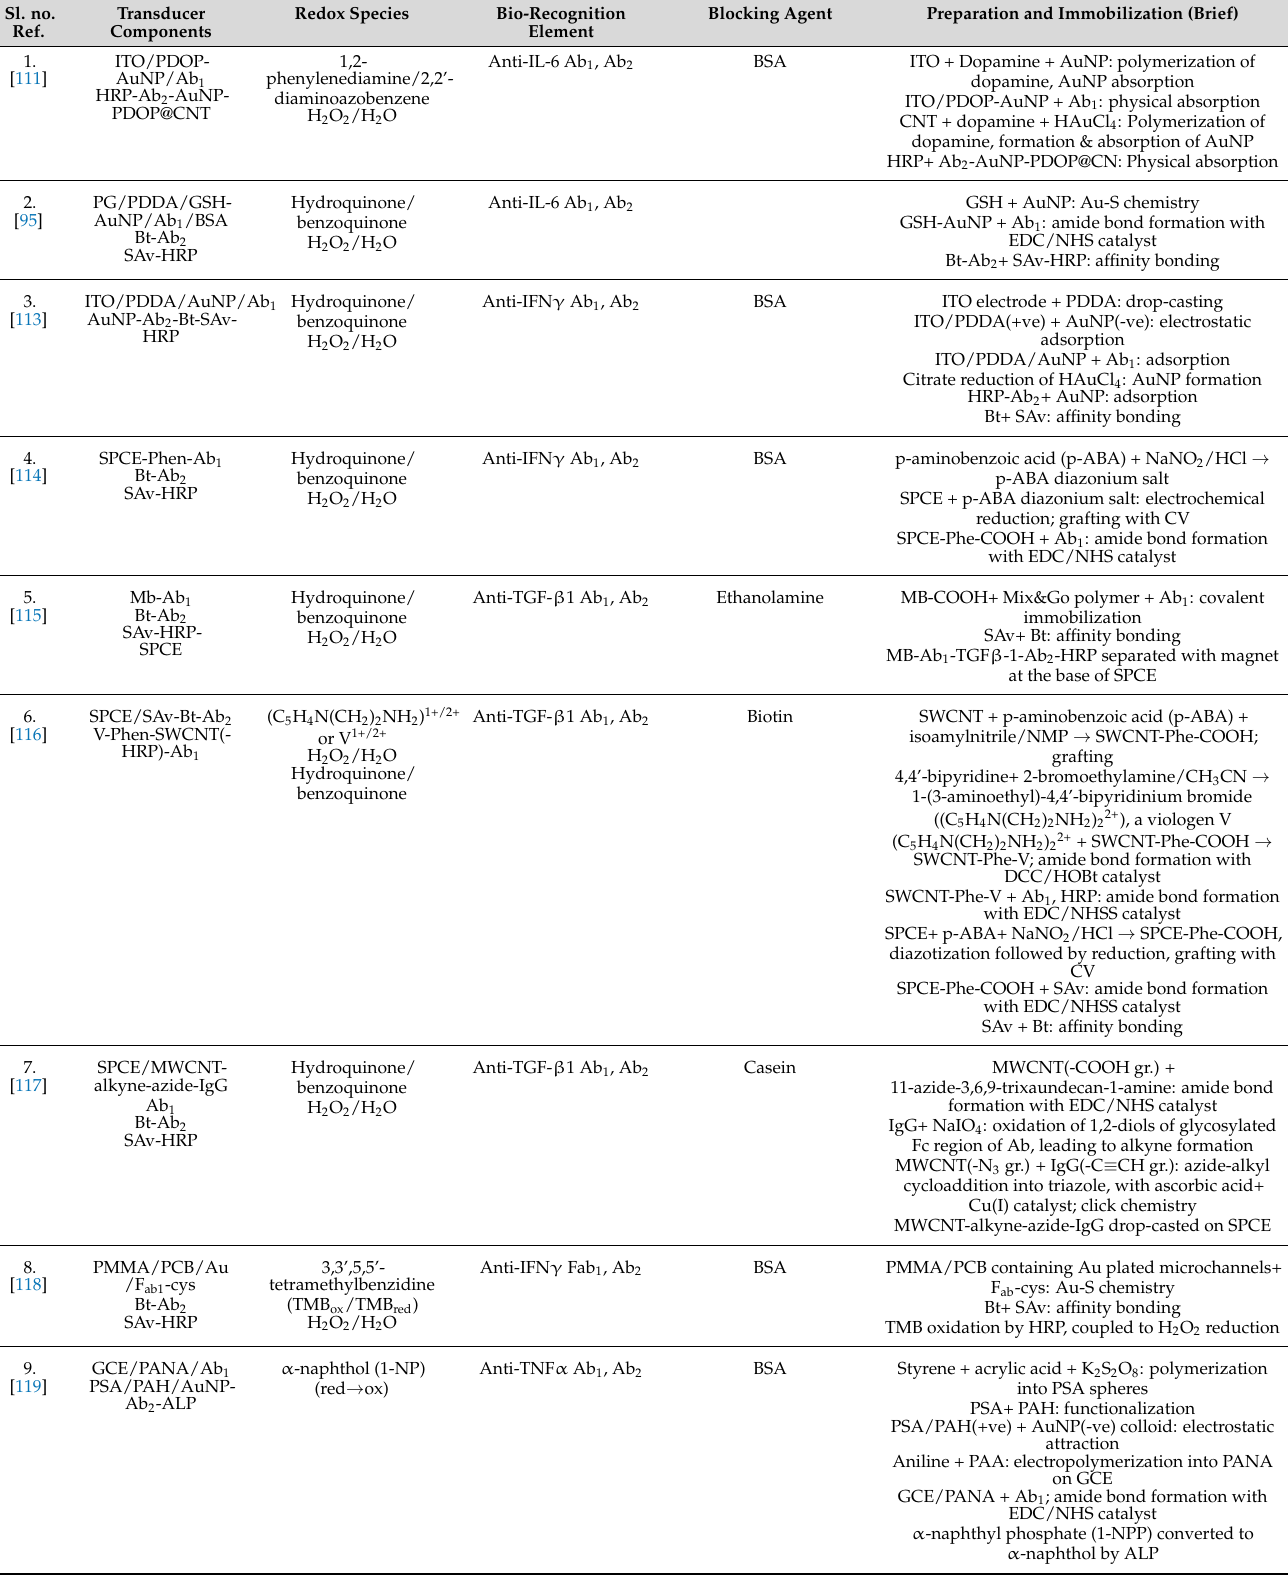
Table 3. Enzyme-labeled immunosensors: Design and sensor